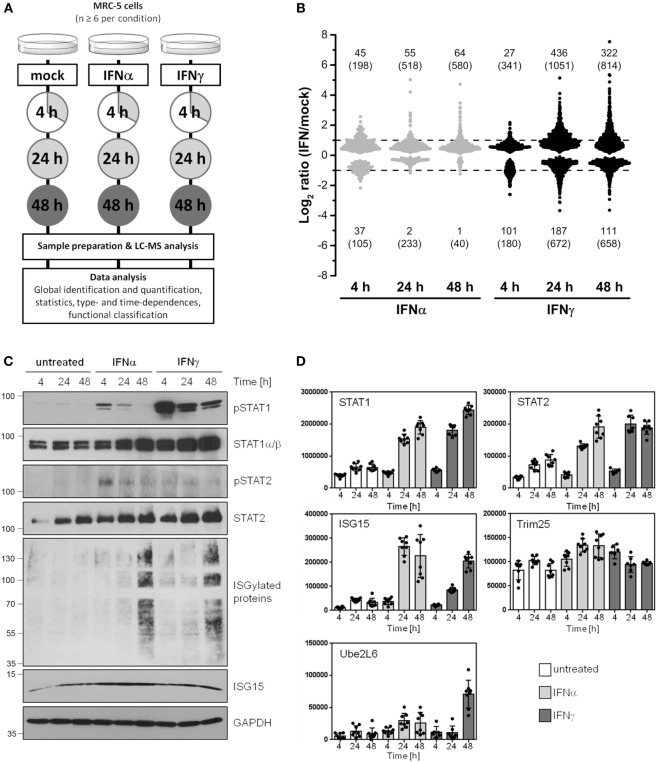
Global identification and quantification of interferon (IFN)-regulated proteins in human cells. (A) General design of the conducted proteomics study. (B) Overview of significantly regulated proteins (p < 0.05) depending on the IFN type (IFNα: gray, IFNγ: black) and exposure times (4, 24, and 48 h). Fold change thresholds (twofold regulation) are indicated as dashed lines. The number of proteins passing the significance threshold is shown in brackets. The numbers of proteins satisfying significance as well as fold change criteria are indicated without brackets. (C) Experimental conditions as in (A), but cells were harvested and lysed for immunoblot analysis using indicated antibodies. The lines and numbers on the left depict the migration of the marker proteins with indicated molecular weights in kDa. (D) The normalized abundances of the same proteins (or their regulators) shown in (C) calculated by use of the MS data are depicted. As in all analyses, unstimulated controls are depicted in white, IFNα stimulation in light gray, and IFNγ stimulation in dark gray bars, respectively. Individual quantifications (n = 6–8) are indicated as dots, bars depict mean values with SD (error bars).